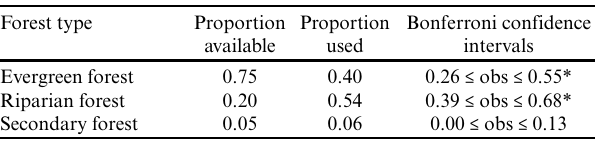
Table 3 . Proportional availability and use of three forest types by Northern Mealy Amazons, with Bonferroni confidence intervals, in tropical moist forest of Los Chimalapas, Mexico, during the breeding season of March 2014. * = P <